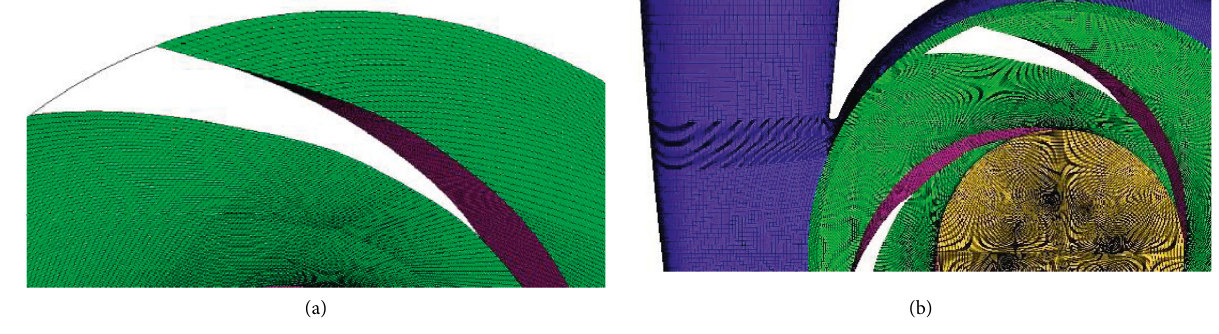
Figure 2: Mesh detail of the pump. (a) Impeller and (b) pump.